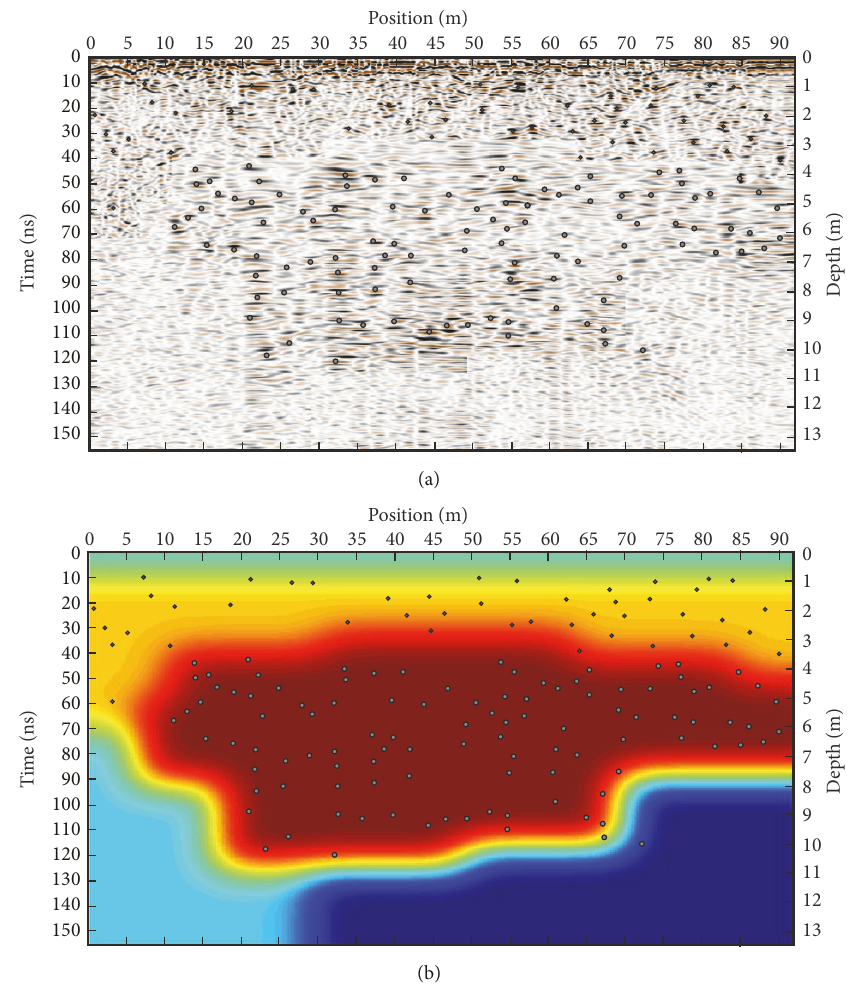
Figure 12: (a) The position of each rock and (b) the interface of LPR CH-2